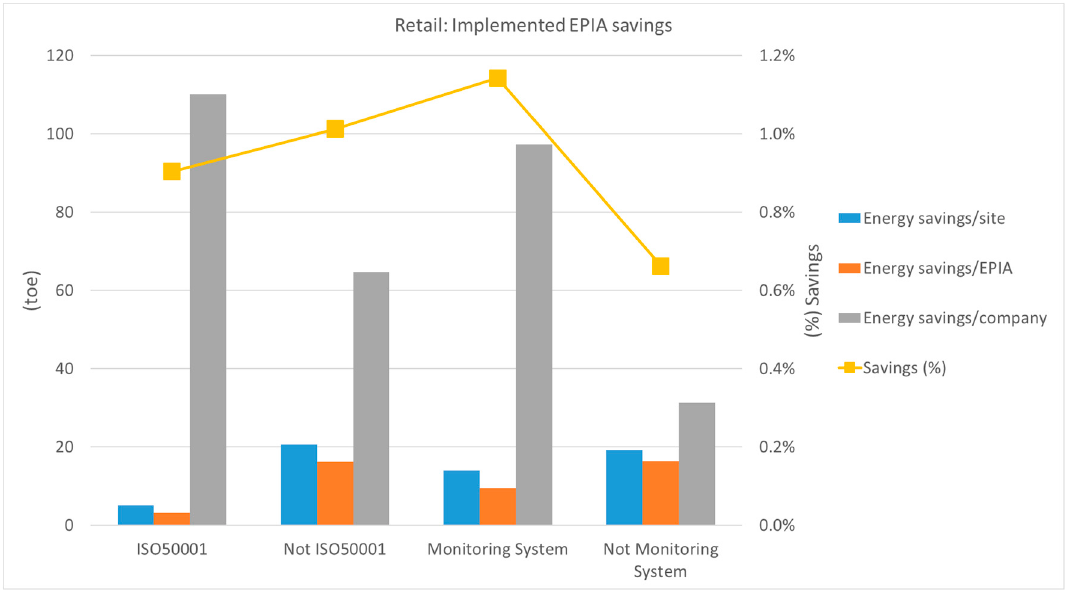
Figure 7. Retail: implemented EPIA savings.